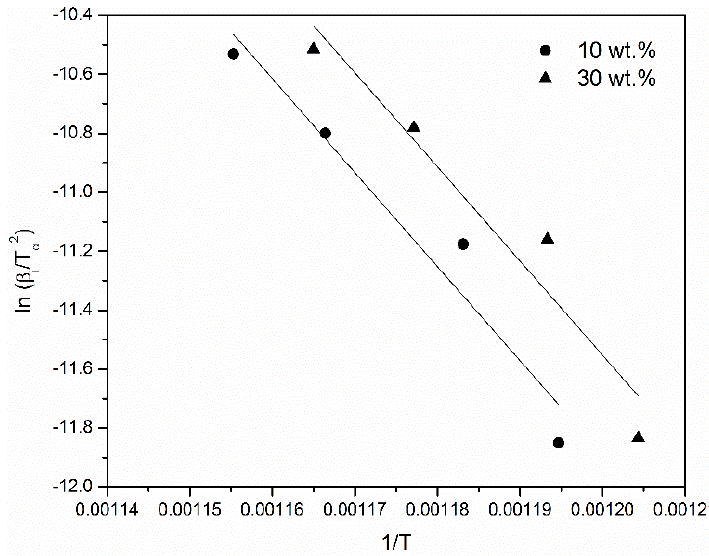
Figure 12. Kissinger-Akahira-Sunose (KAS) plots for PINGS-10 and PINGS-30. The activation energy of imidization was found to be in the range of 50–70 kJ/mol as shown in Figure 11, while that for the degradation of PINGS composites was found to be in the range of 245–272 kJ/mol as shown in Figure 13.